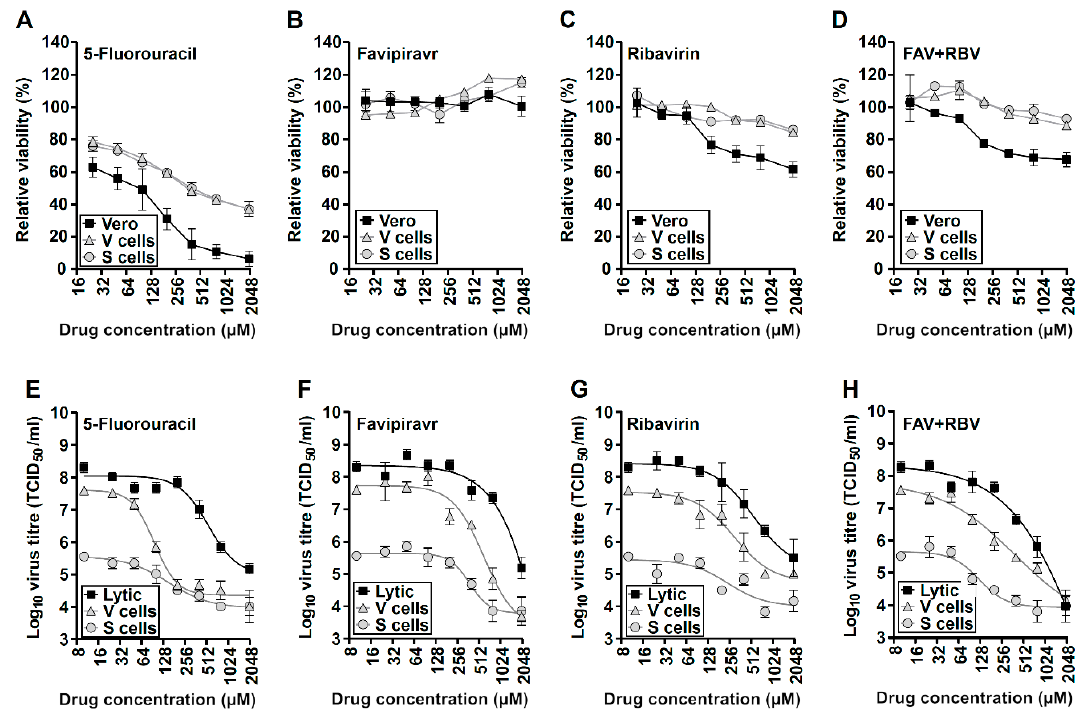
Figure 4. Antiviral nucleosides inhibit USUV persistent infection in Vero cells. A-D, Cellular toxicity displayed by di ff erent nucleoside drugs was tested upon V p39 (grey triangles), S p39 (grey circles), and uninfected Vero cells (black squares), using the CellTiter–Blue Cell viability assay (Promega), which accounts for living cells. Cellular viability was measured in cells treated with increasing concentrations of 5-fluorouracil (FU) ( A ), favipiravir (FAV) ( B ), ribavirin (RBV) ( C ), or FAV + RBV ( D ) at 48 h and represented as a relative value to untreated cells ( n = 3). ( E , F ) Viral titers recovered in V p39 (grey triangles), S p39 (grey circles), and lytically-infected Vero cells (black squares), after 48h in the presence of nucleoside drug analogues. Values observed in cells treated with increasing concentrations of FU ( E ), FAV ( F ), RBV ( G ), or FAV + RBV ( H ). To this assay, naïve uninfected Vero cells (black squares) were inoculated with wild type USUV at an MOI of 0.01, and after adsorption the cells were treated with drugs for 48 h. Persistently-infected V p39 and S p39 were directly treated with drugs for 48 h. Every time point is the average of three ( n = 3) biological replicas ( ± SEM). In FAV + RBV graphs (D,H) the ordinate values represent the concentration for each drug individually (e.g. 400 µ M refers to a cocktail of 400 µ M FAV and 400 µ M RBV, or 800 µ M nucleosides).